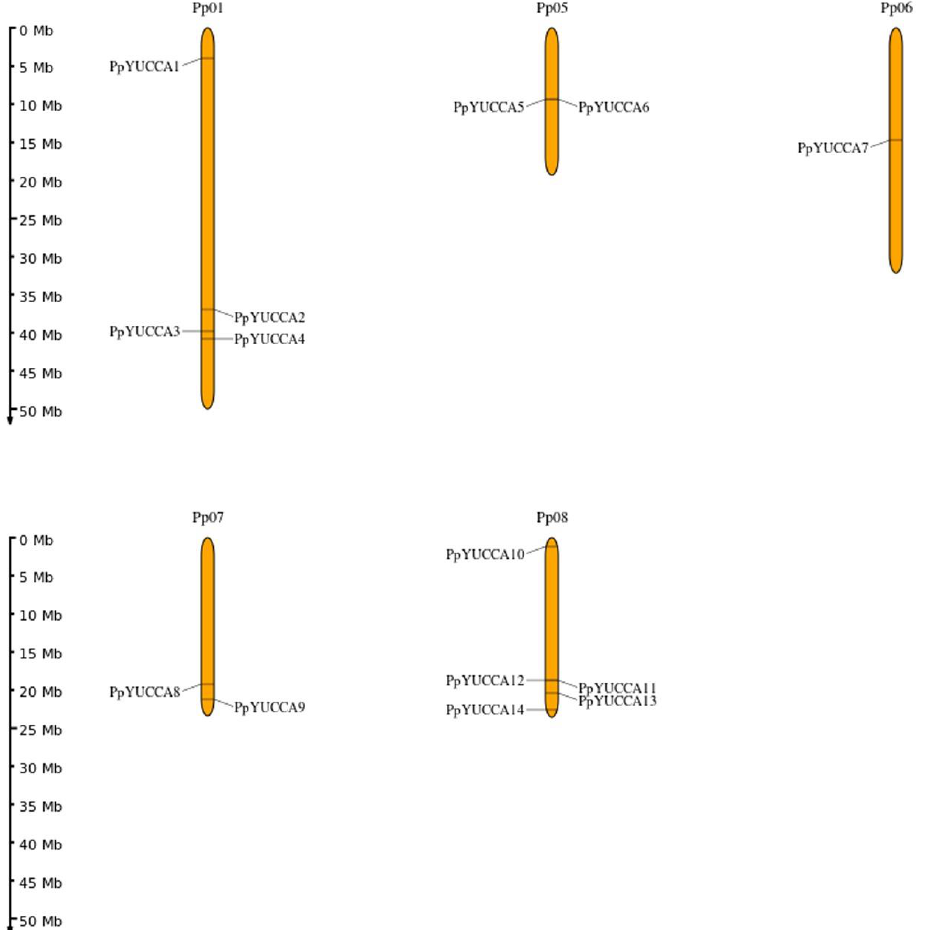
Figure 2. Structure of Prunus persica var. pendula YUCCA genes. Introns, exons, and untranslated regions (UTRs) are represented by black lines, deep orange boxes, and blue boxes, respectively.